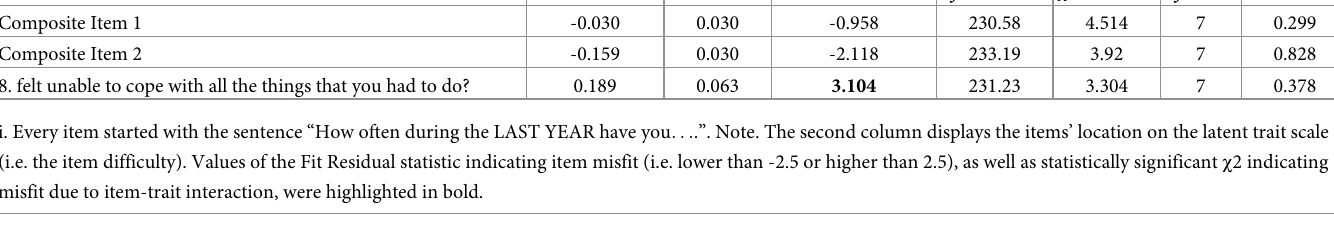
Threshold ordering: Composite Item 1 and 2 had disordered thresholds and Item 8 thresh-